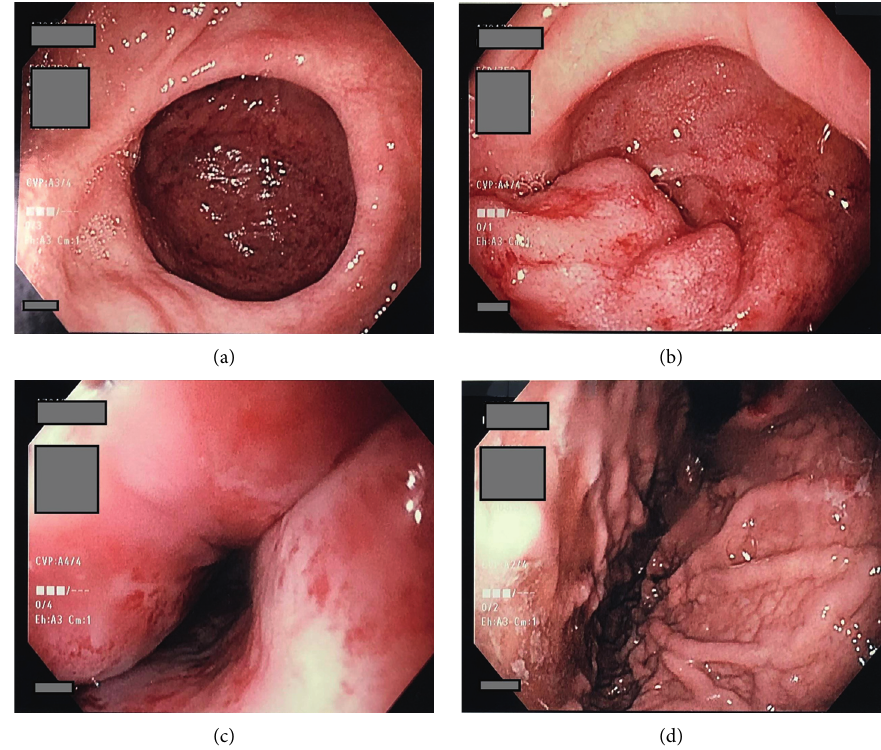
Figure 2: Endoscopic view of the gastric diverticulum, located in the antrum. (a) Bottom left-large antral diverticula. (b) Top left- inflammation within the diverticulum. (c) Bottom right-erosive esophagitis. (d) Top right-retroflex look at fundus/cardia.